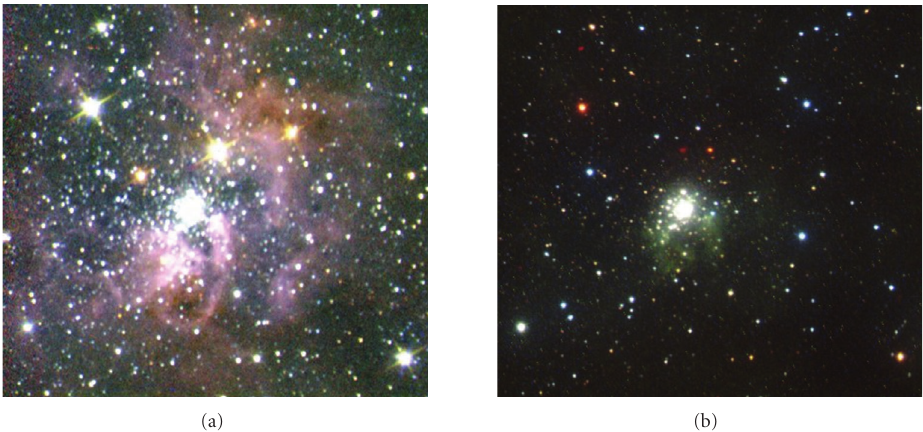
Figure 2: NGC3606 imaged by the REM cameras. (a) The color composite of the REMIR J, H, and K filters. (b) Photo the composition of the ROSS V, R, and I images.